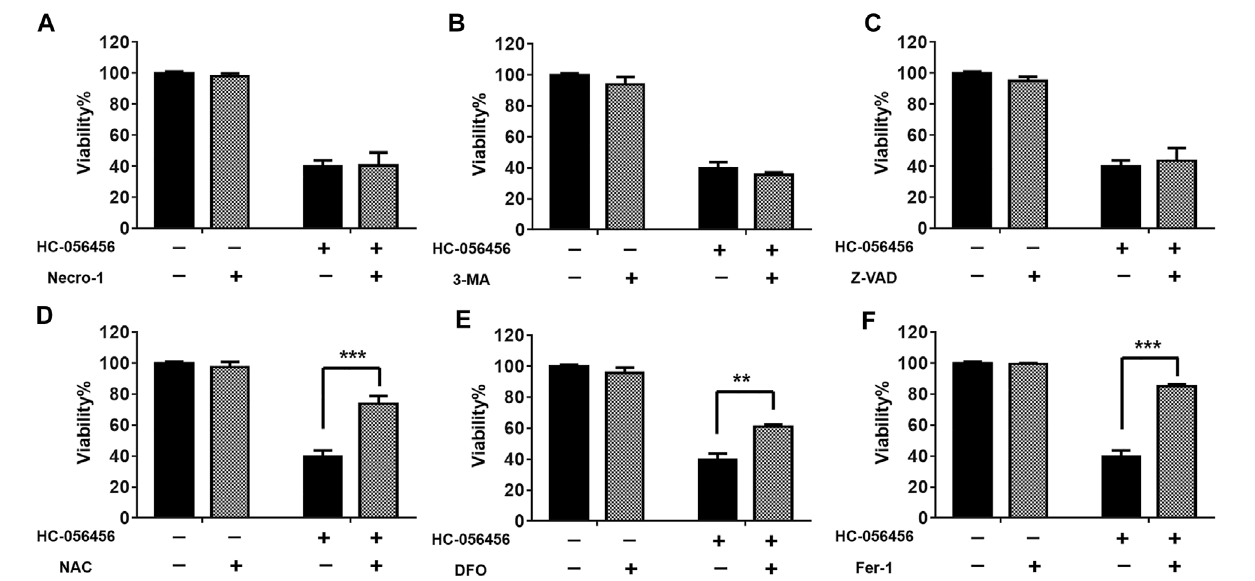
FIGURE 2 | The viability of MGC-803 cell lines after the treatment of HC-056456 (10 μ M) with (A) necroptosis inhibitor Necro-1 (10 μ M) (B) autophagy inhibitor 3- MA(2 mM) (C) apoptosisinhibitorZ-VAD(10 μ M)andferroptosisinhibitors (D) NAC(5 mM) (E) DFO(200 μ M) (F) andFer-1(2 μ M).Resultswererepresentedasmean± SD, ** p < 0.01, *** p <